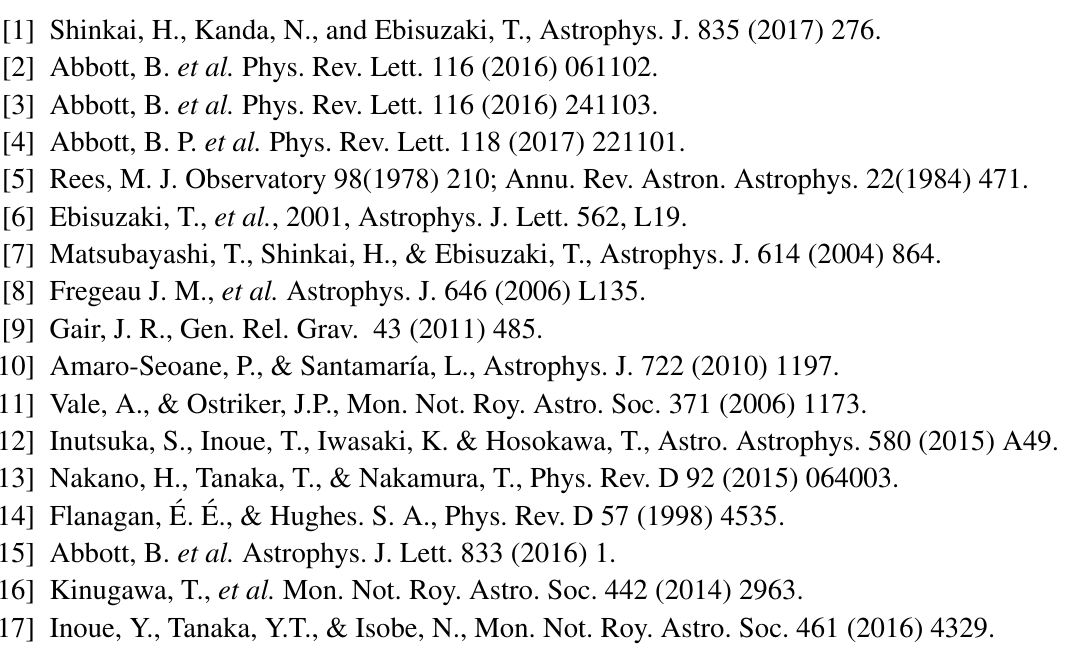
yr − 1 from their Population III model. Inoue et al. [17] estimate as < 60 yr − 1 from their BH merger model inferred from the luminosity function of ultraluminous X-ray sources. However, our model predicts BH mergers with M > 100 M , which will be a key to test our model in the ⊙